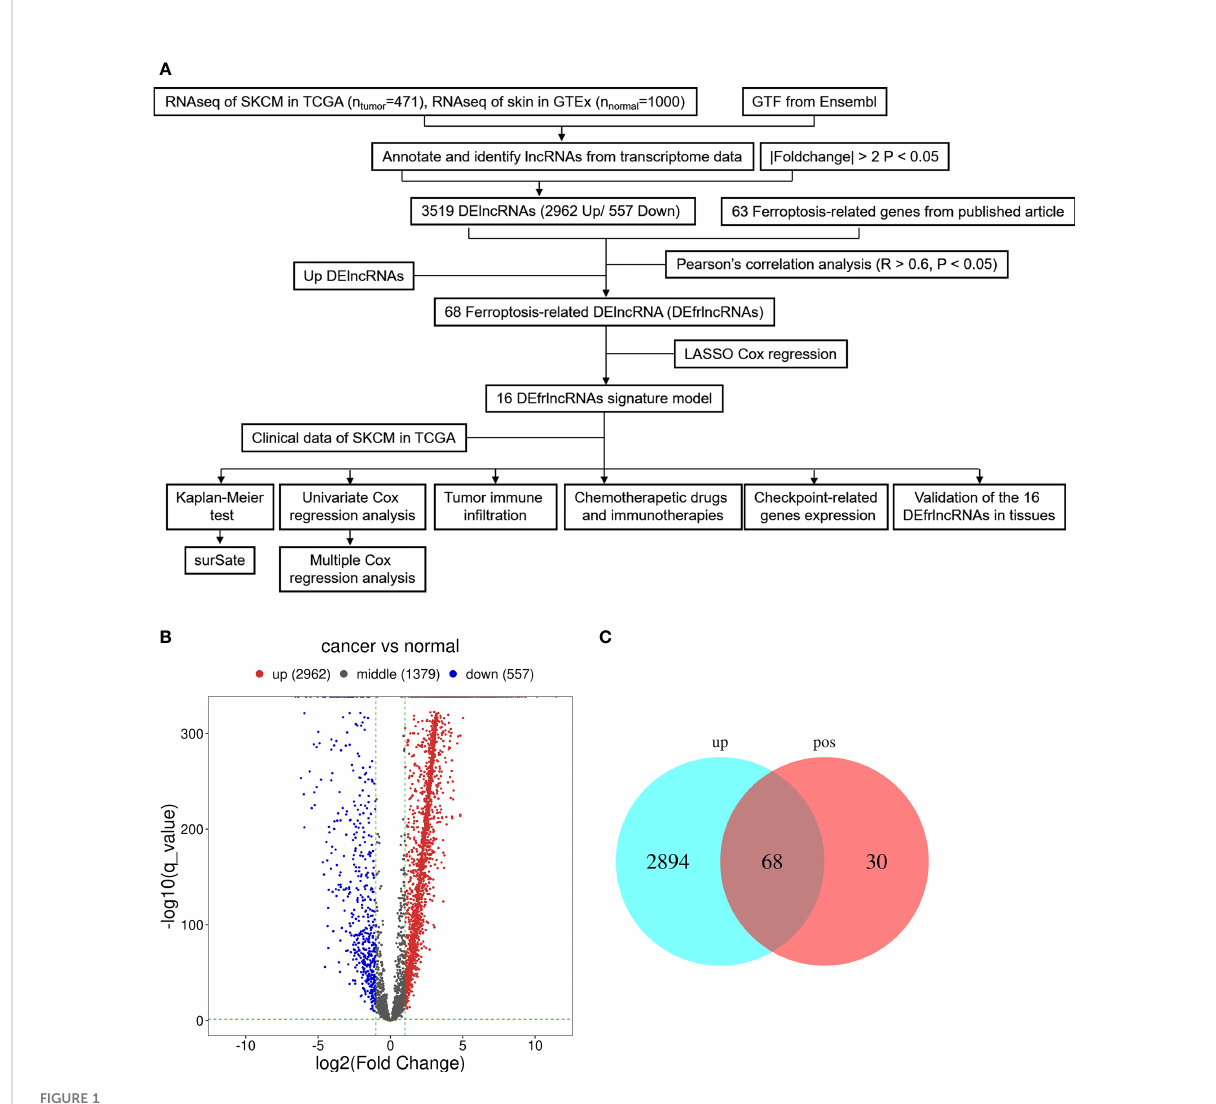
FIGURE 1 Presentation of differentially expressed lncRNAs between SKCM samples and samples from normal tissues (log2 fold change>2, adjusted p- value<0.05). (A) Flow chart of the analytical process in this study. (B) A volcano map of lncRNAs that are differentially expressed. Red abd blue dots represent the genes that are signi fi cantly up-regulated and downregulated, respectively. (C) A Venn map for the up-regulated ferroptosis- related